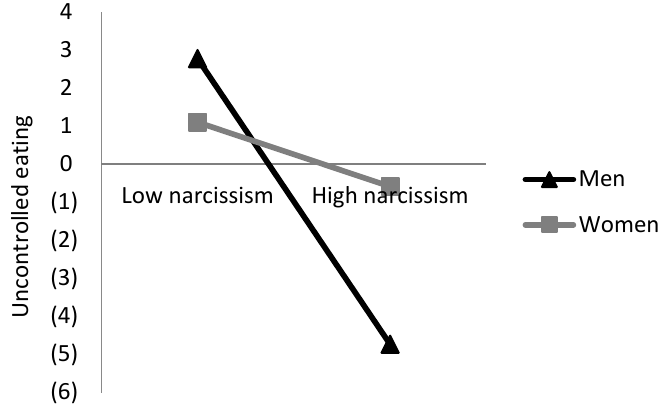
Figure 1. Uncontrolled eating as a function of narcissism and sex.